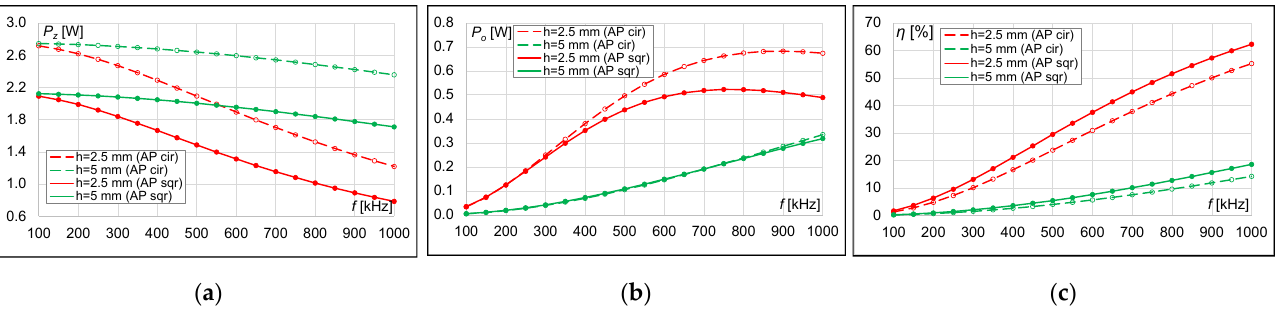
Figure 24. Results for the aperiodic system with circular or square coils with r = 5 mm and the number of turns n = 15 at two distances ( h = 2.5 mm and h = 5 mm): ( a ) transmitter power, ( b ) receiver power, ( c ) power transfer efficiency.